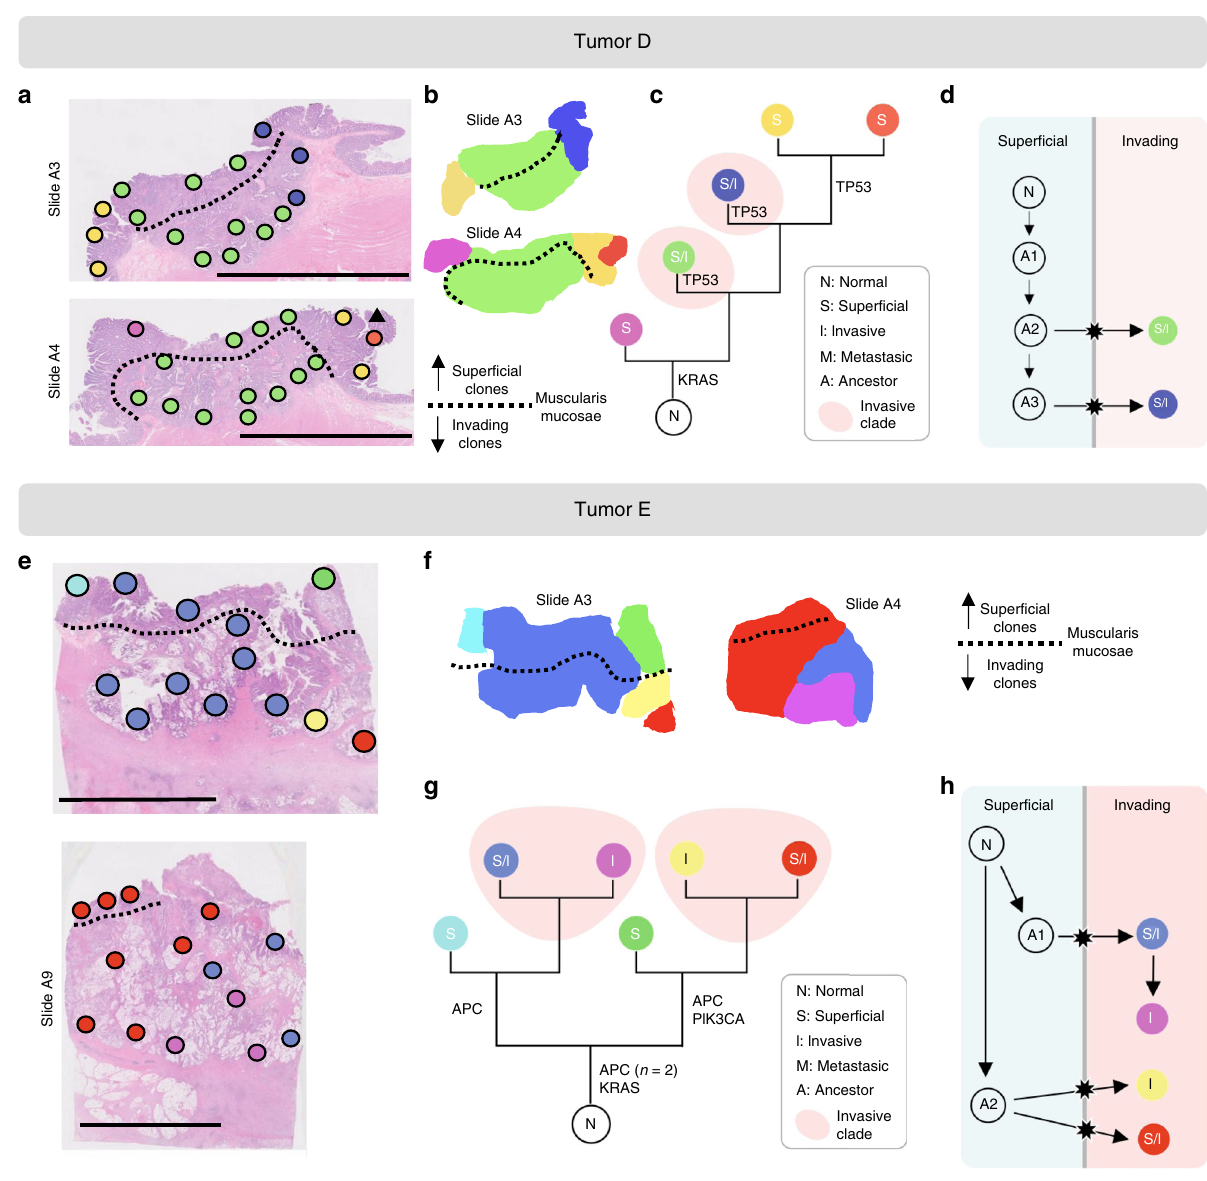
Fig. 3 Phylogeographies of tumors D and E. a , e Spot genotypes were localized on the sections and sections annotated for super fi cial and invasive regions (scale bar: 1 cm). Invasion is de fi ned as migration below the muscularis mucosae (dotted line). b , f Contiguous clone maps reveal vertically arranged subclones that share super fi cial and invasive phenotypes. c , g Maximum parsimony algorithms were used to reconstruct phylogenetic trees for the subclones. d , h The ancestry of invasive subclones were reconstructed under the assumption that cells migrate from super fi cial to invasive regions, but not vice